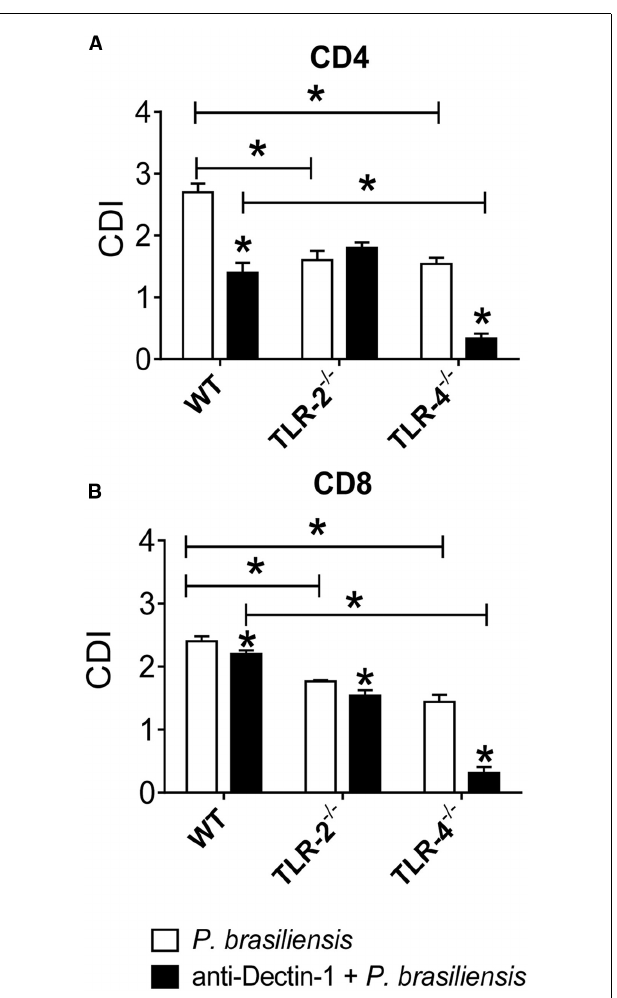
FIGURE 5 | Dectin-1 collaborates with TLR-4 in the induction of T cell proliferation. BMDCs from WT, TLR-2 (cid:0) / (cid:0) , and TLR-4 (cid:0) / (cid:0) mice were treated or not with anti-Dectin-1 antibody for 30 min and infected with viable P. brasiliensis yeasts for 2 h. Splenic lymphocytes from uninfected WT, TLR-2 (cid:0) / (cid:0) , and TLR-4 (cid:0) / (cid:0) mice were previously labeled with CFSE (5 mM) and co-cultured with anti-Dectin-1 treated or untreated DCs. After 5 days, the cells were adjusted to 1 (cid:2) 10 6 , labeled with specific anti-CD4 (A) and CD8 (B) antibodies and analyzed by flow cytometry. The lymphocyte population was gated by FSC/SSC analysis. The results are expressed as frequency of positive cells. Data are means (cid:6) SD of five wells per group from three independent experiments (* P < 0.05).